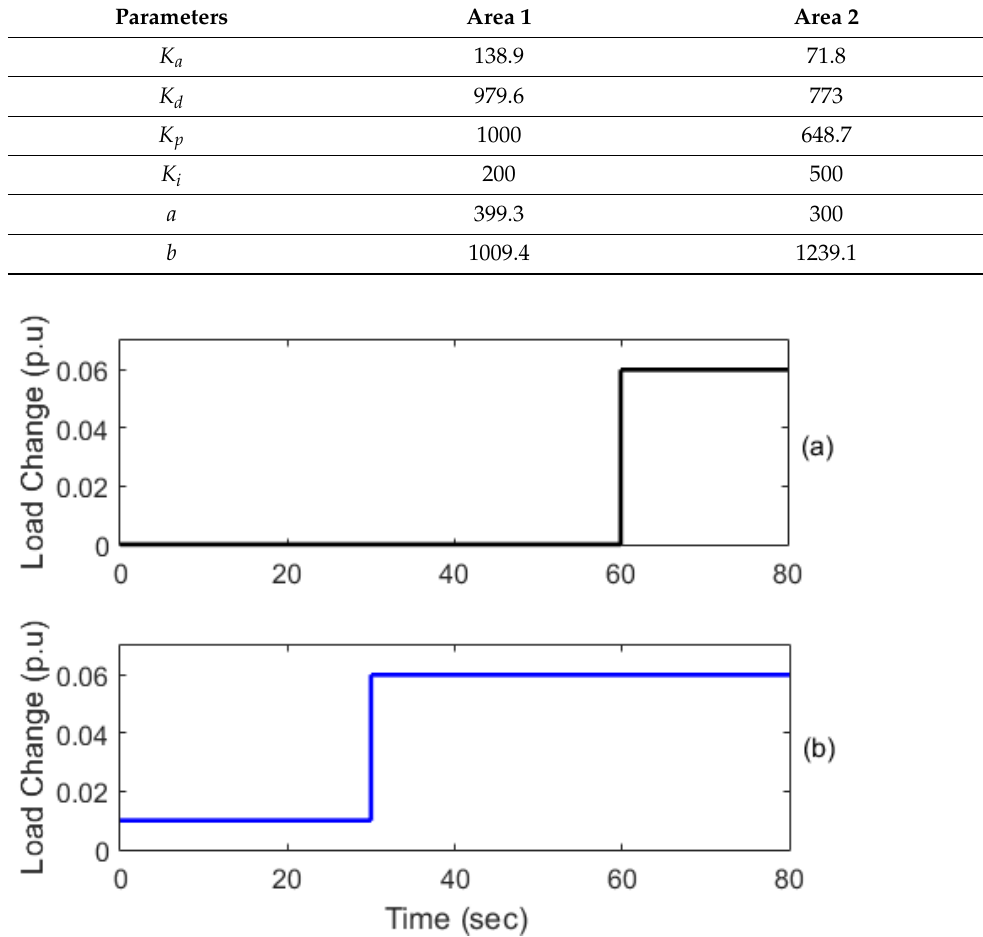
Figure 5. Load variations scenario in ( a ) area 1 and ( b ) area 2.